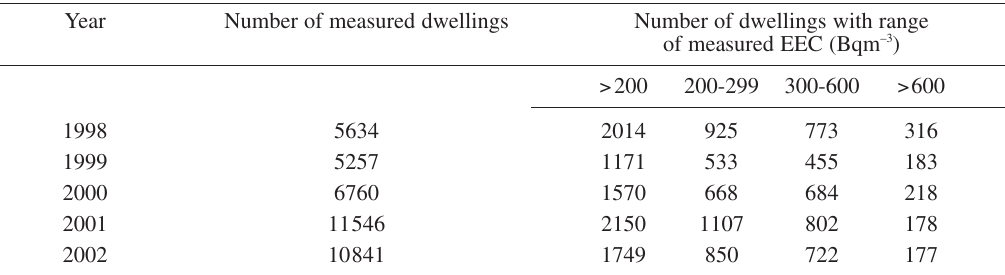
Table I. Number of indoor Rn measurements in the Czech Republic in